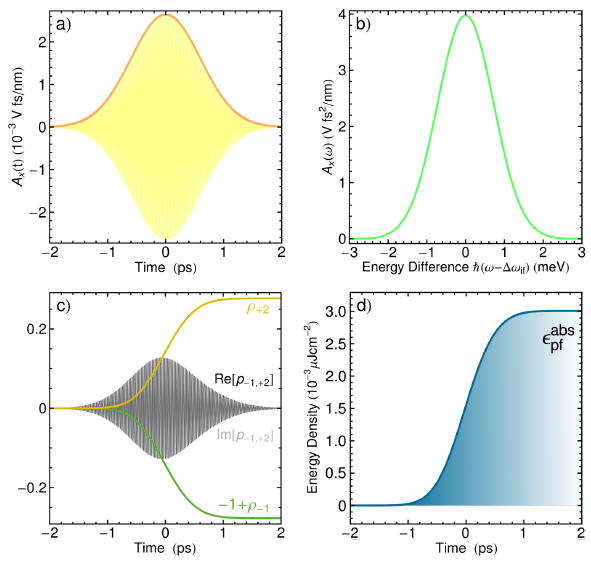
Figure 7: Optical excitation pulse. Temporal evolution (a) and Fourier transform (b) of the x-component of A ( t ) for a σ + -polarized excitation pulse with a pump fluence ϵ pf = 0.14 µJcm −2 , a width = 1ps , and an excitation energy of 175meV which is in reso- σ exp FWHM nance with the inter-Landau level transition LL −1 → LL +2 at B = 4T . The thick orange line in (a) represents the Gaussian envelope of the pulse. Furthermore, the occupations ρ −1 ( t ) and ρ +2 ( t ) as well as the polarization p −1,+2 ( t ) are illustrated (c), and the increase of the energy density corresponding to the absorbed pump fluence ϵ abs shown (d).